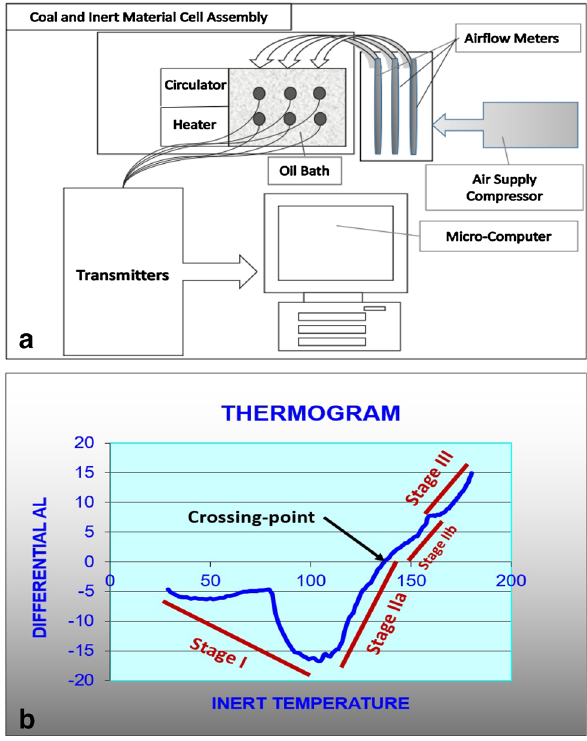
Fig. 3 a Wits-Ehac test apparatus set-up (Wade et al. 1987); b A typical differential analysis